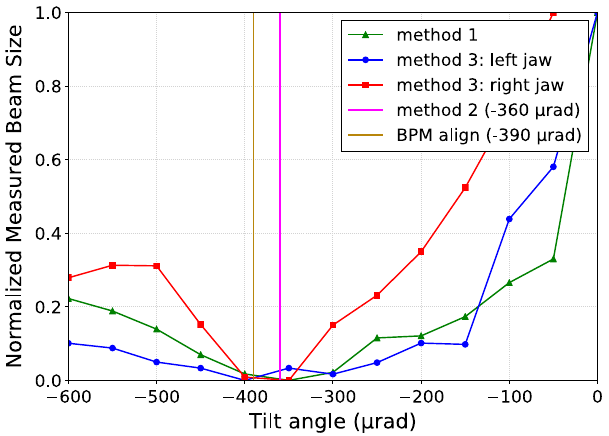
FIG. 16. Angular alignment results for the TCSG.D4L7.B1 using the three